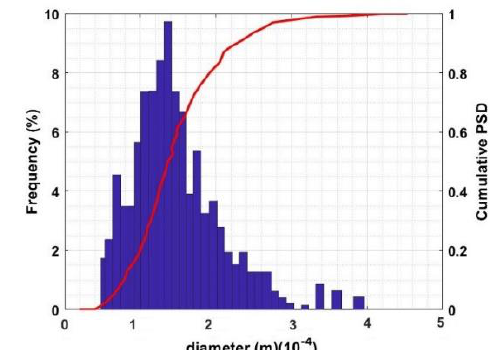
Fig. 3 Particle size distribution of dry SAP as reported in Ref